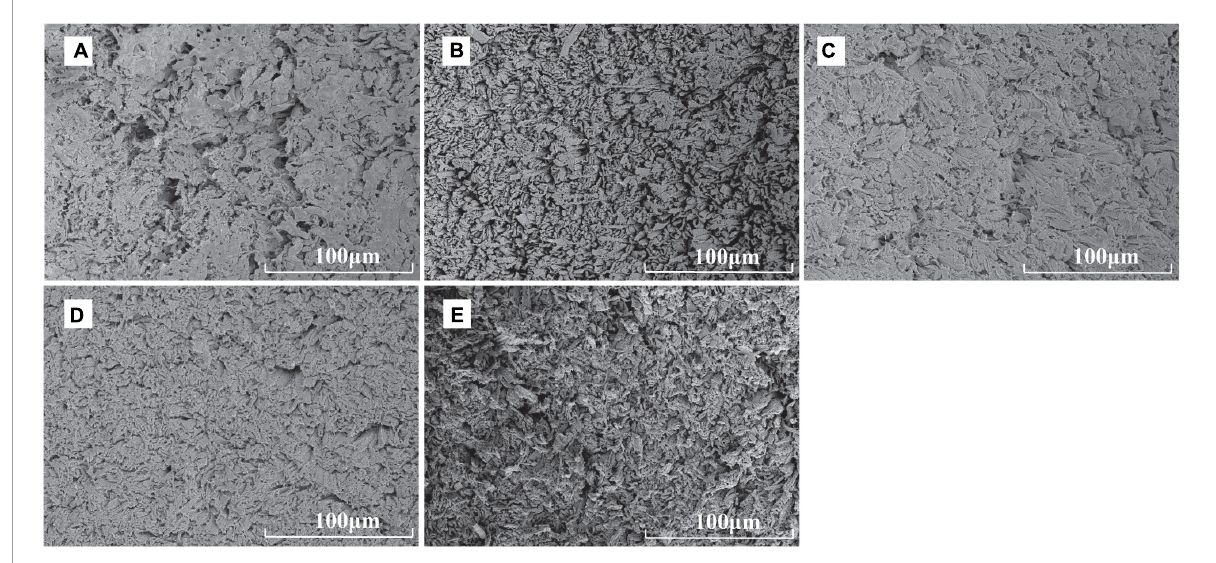
FIGURE4 Scanning electron micrographs of raw and cooked scallops (500 × magnification, (A) CK, the control group; (B) BS, boiled sample; (C) : RS, oven-heated sample; (D) FS, fried sample; (E) MS, microwaved sample).